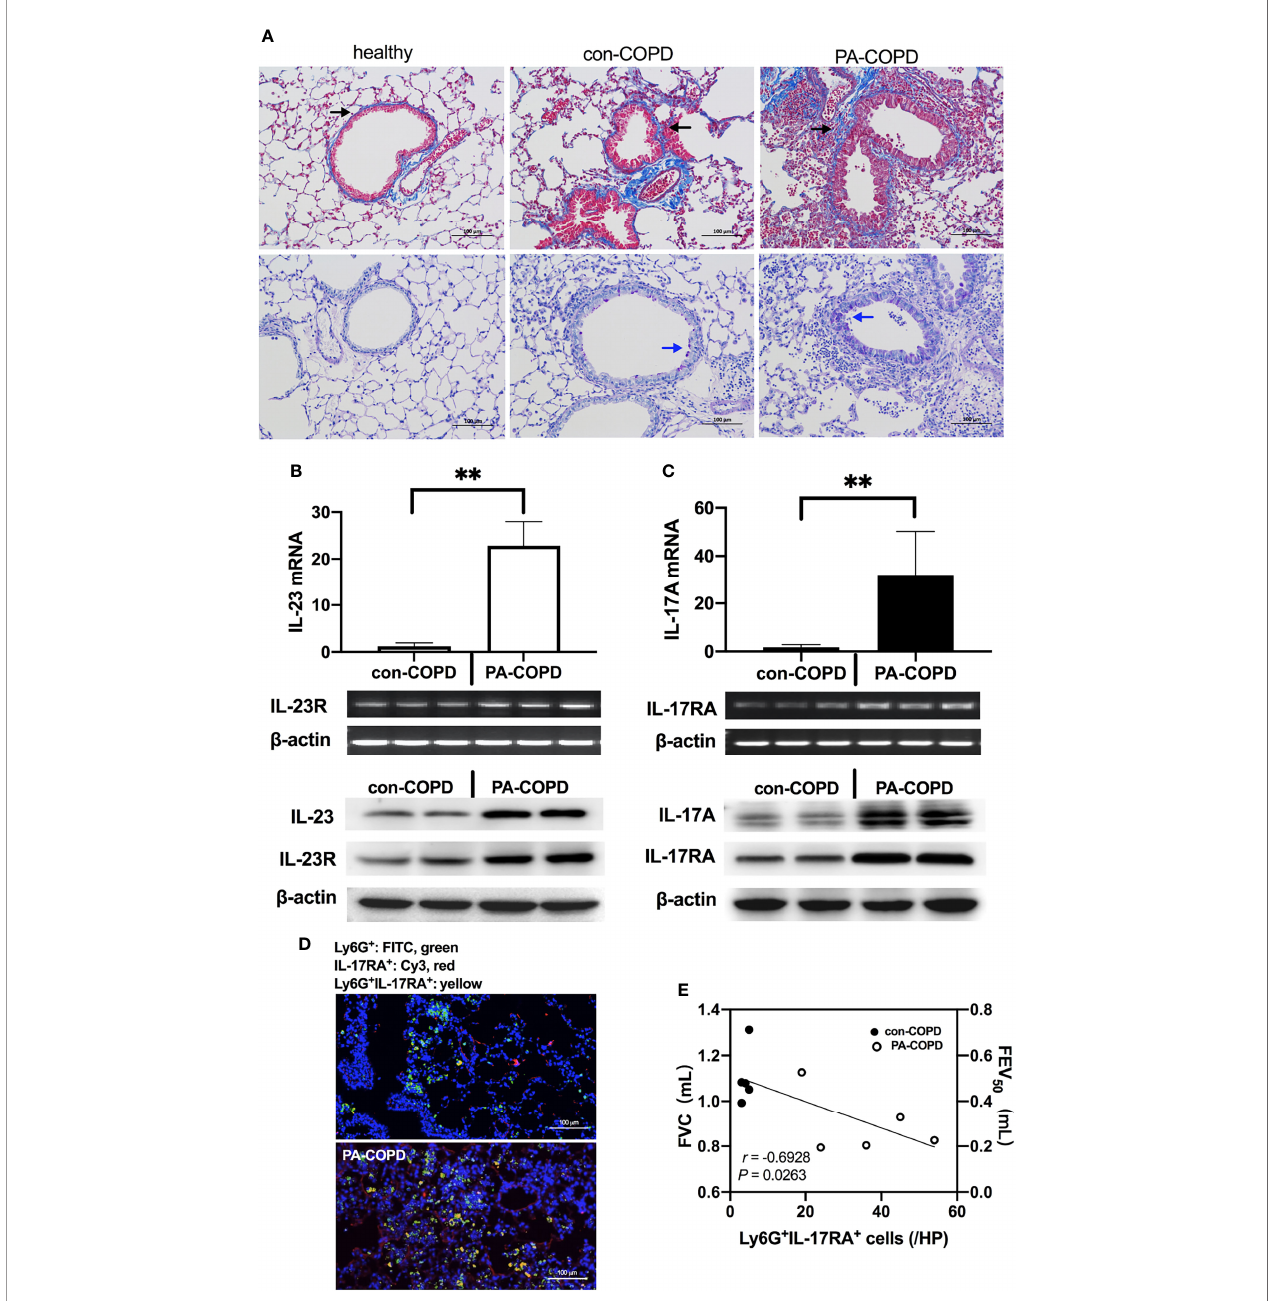
FIGURE 2 | P. aeruginosa infection increased IL-23/IL-17 axis signaling in the lungs of COPD mouse models. C57BL/6 mice were exposed to ozone twice a week for 6 weeks to establish COPD models, and then were intrabronchially inoculated with sterile agar beads (con-COPD) or 1.0 × 10 5 CFU agar-entrapped P. aeruginosa (PA-COPD). Lungs were excised at one day post inoculation, and were sectioned and stained with masson trichrome to measure tissue fi brosis ( A , upper row), and PAS to quantify glycogen [ (A) , bottom row]. Blue areas around airways were identi fi ed as collagen deposition (indicated by black arrows), and purple areas within tracheal cavity were identi fi ed as mucus production and goblet cell hyperpasia (indicated by blue arrows). Internal scale bar = 100 m m. Quantitative real-time PCR, semiquantitative RT-PCR, and western-blot analysis of IL-23 and its receptor (B) , and IL-17A and its receptor (C) were performed using lung tissues. b -actin serves as the loading control. Data were presented as mean ± SD ( n = 5 per group). ** P < 0.01. The lungs were processed for immuno fl uorescent analysis (D) , and the sections were stained with anti-IL-17RA (red) and anti-Ly6G (green), and DAPI (blue) for nuclei. Internal scale bar = 100 m m. Two independent experiments were performed. Correlation analysis showed that there was a signi fi cantly negative correlation between the numbers of Ly6G + IL-17RA + cells and the spirometry results (E) . COPD, chronic obstructive pulmonary disease; CFU, colony-forming units; IL, interleukin; FVC, forced vital capacity; FEV 50 , volume expired in the fi rst 50 ms of fast